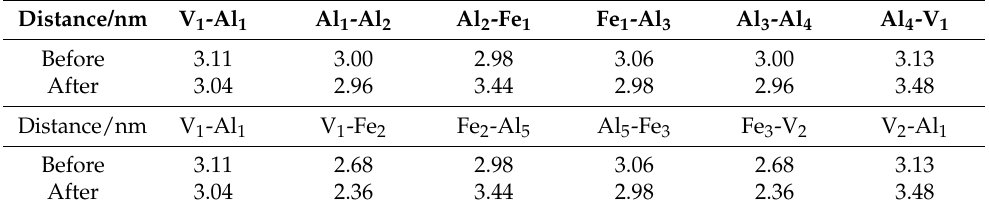
Table 3. Distance between adjacent center atoms before and after dehydroxylation.